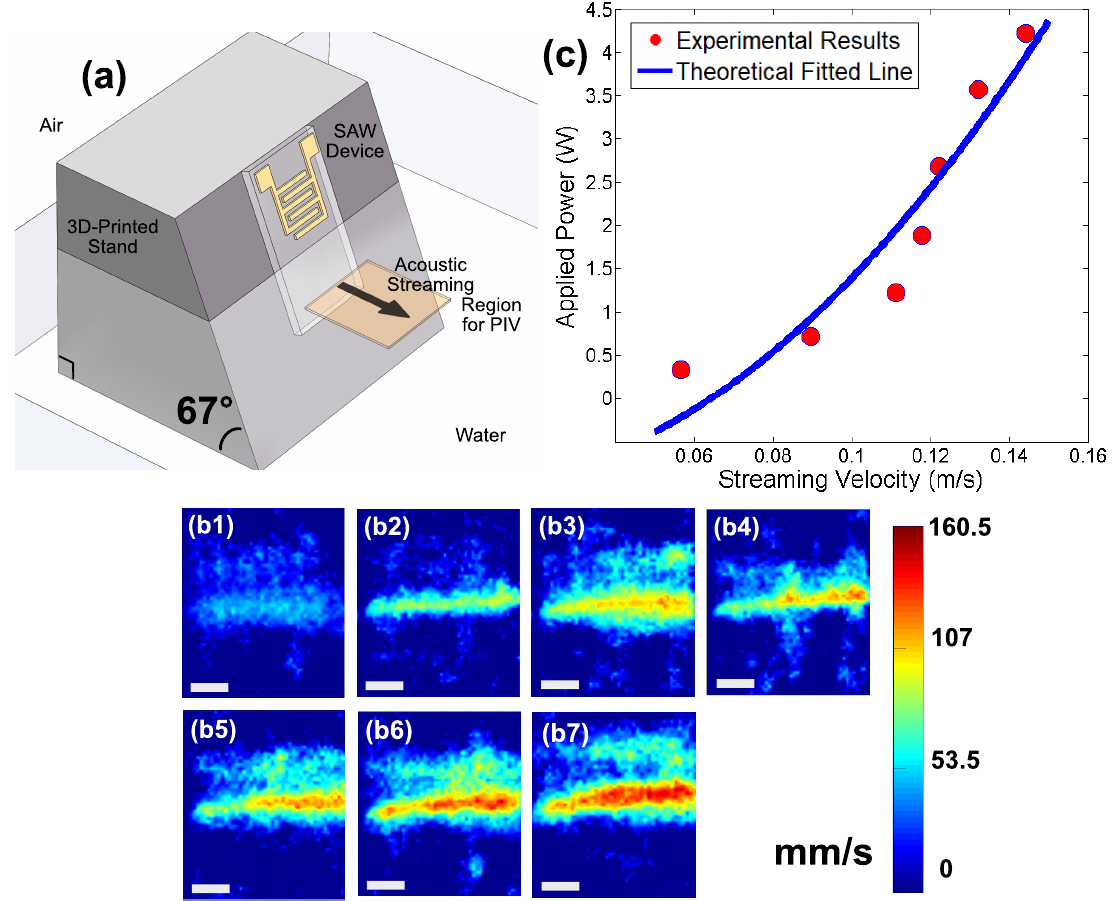
Figure 3. ( a ) Mounting the SAW device to visualize the acoustic streaming velocity field that it generates. ( b ) With the SAW device at the left, a top view of the PIV-derived acoustic streaming flow profile in 90% water/10% glycerol indicates that acoustic streaming increases as the applied power is increased from (b1) 330 mW, (b2) 710 mW, (b3) 1.22 W, (b4) 1.89 W, (b5) 2.68 W, (b6) 3.57 W, and (b7) 4.23 W, respectively. Scale bar: 2 mm. This produces a maximum fluid flow speed in the acoustic streaming jet as ( c ) plotted with respect to the applied power, with a fitted line based on the theoretical model of the acoustic streaming